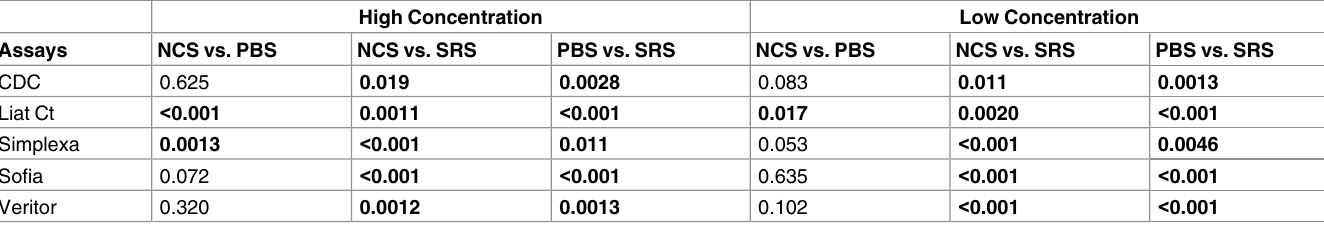
Table 5. P-values from statistical analysis of matrix comparison